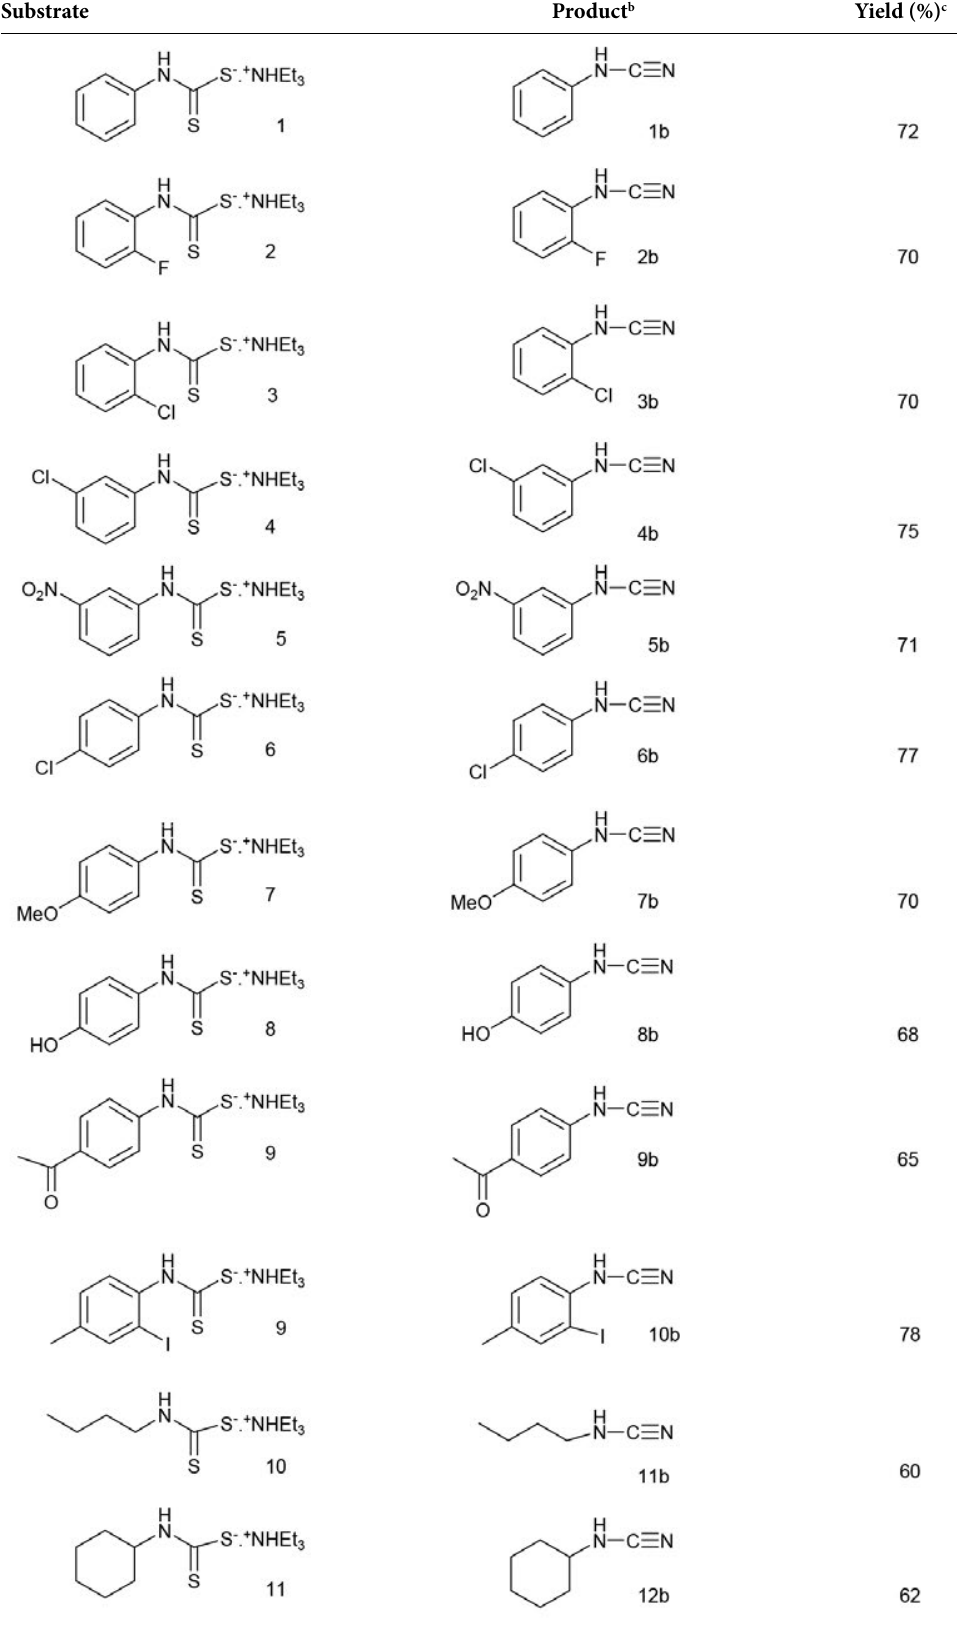
Table 2. Preparation of cyanamides from dithiocarbamates and TPATB a